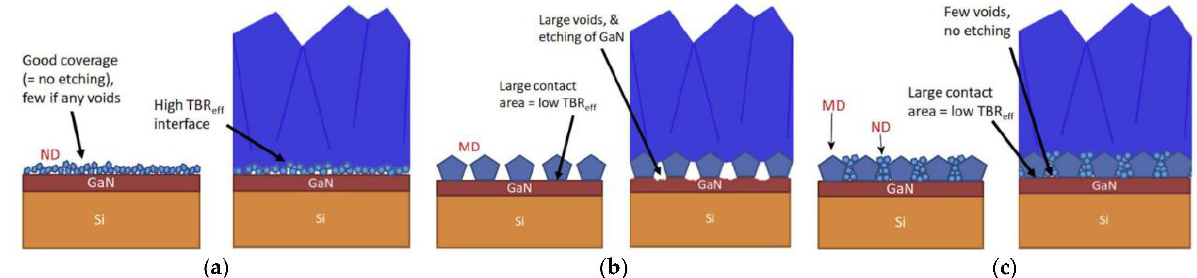
Figure 11. Mixed-size diamond-seeding process. ( a ) Seeding with ND particles alone, ( b ) seeding with MD particles alone, and ( c ) two-step seeding with different size particles [109].